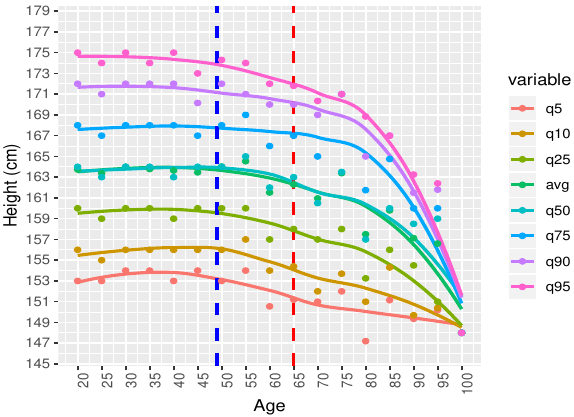
Figure 11. Male Height for Age 20–100: 5 years of intervals ( N =